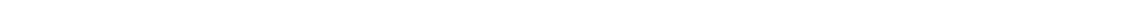
Fig. 4 Mutant Kras drives basal and IL-1 β -induced non-canonical NF- κ B signaling and drug resistance. a Rel A and Rel B binding of nuclear extracts of MC38 cells stably expressing a control plasmid (p C ), a mutant dominant-negative form of ΙκΒα (p ΙκΒα DN), control shRNA (sh C ), or anti- Kras shRNA (sh Kras ) relative to Raji leukemia cells by NF- κ B ELISA ( n = 3 experiments). b Immuno fl uorescent detection of Rel A and Rel B in MC38 cells showing increased nuclear Rel B (arrows) and its disappearance in cells expressing sh Kras . c IKK α immunoblots of cytoplasmic and nuclear extracts of LLC and MC38 cells expressing sh C or sh Kras . ( n = 3 experiments). d , e MTT data ( n = 3 replicates/data-point) and mean (95% CI) IC 50 values ( n = 3 experiments) of MC38 cells stably expressing sh C or sh Kras treated with bortezomib ( d ) or IMD-0354 ( e ) for 72 h. P , probability of no difference between cell lines by extra sum- of-squares F test. f , g Bioluminescent detection of NF- κΒ activity in Kras MUT ( f ) and Kras WT ( g ) cells stably expressing p NGL and the indicated vectors during 4-h incubation with PBS or 1 nM TNF or IL-1 β ( n = 3 experiments). h , i Data summary ( h ; n = 6 mice/group) and images ( i ) of C57BL/6 mice at 0 and 4 h after intrapleural injection of MC38 or PANO2 cells stably expressing pNGL and the indicated vectors. j Il1r1 mRNA expression by qPCR of Kras MUT and Kras WT cells stably expressing the indicated vectors. k Immunoblots of protein extracts of MC38 and PANO2 cells stably expressing the indicated vectors for NF- κ B members after 4-h incubation with PBS or 1 nM TNF or IL-1 β ( n = 3 experiments). l The above extracts were subjected to EMSA. Super-shift EMSA was performed with the indicated antibodies. IgG antibody served as negative control. Data are presented as mean ± s.d. P , probability of no difference between cell lines by two-way ANOVA. Single, double, and triple asterisks (*, **, and ***): P < 0.05, P < 0.01, and P < 0.001, respectively, for comparison with p C or sh C ( a , f , h , j ) or with PBS ( g ) by Bonferroni